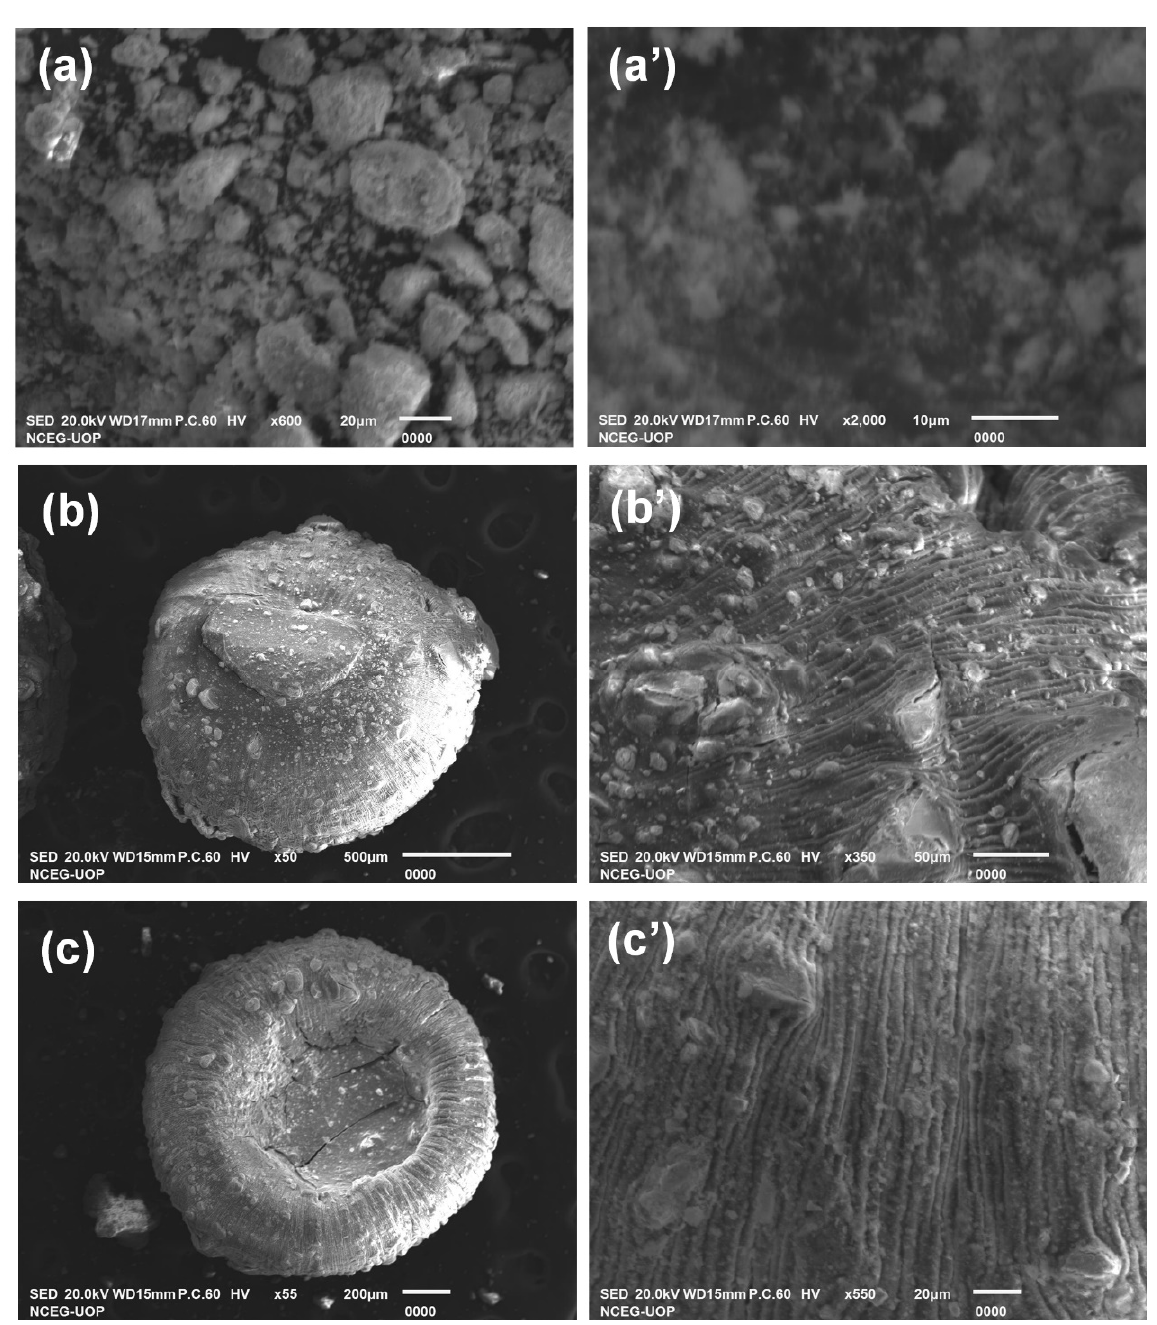
Figure 1. SEM images of ( a , a’ ) Co–CeO 2 , ( b , b’ ) Alg/Co–CeO 2 , and ( c , c’ ) Cu@Alg/Co–CeO 2 .